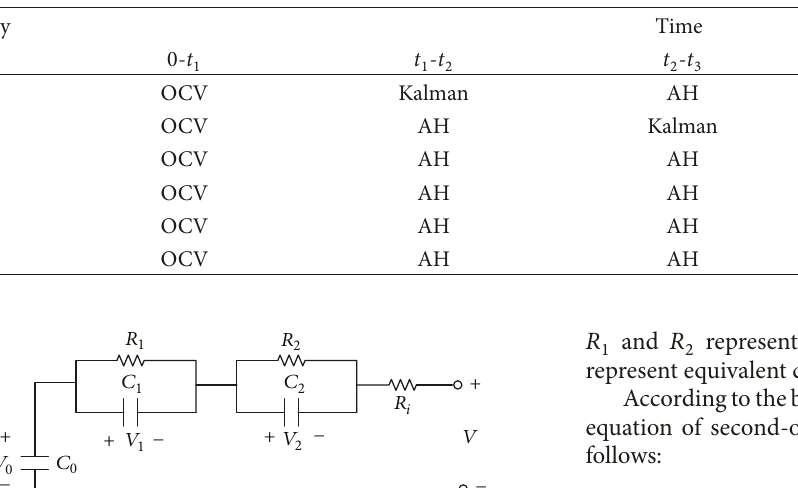
Table 1: Time sequence of new SOC estimation strategy for multiple battery cells.